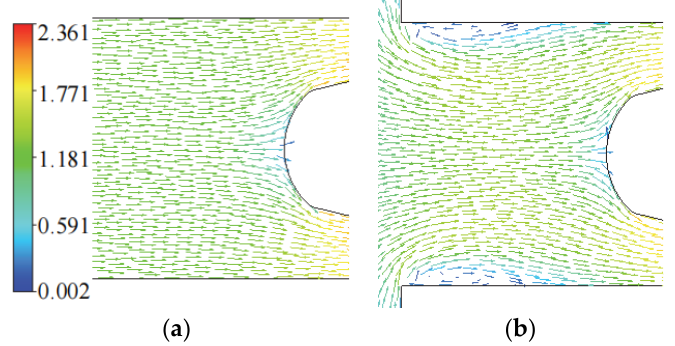
Figure 28. Velocity vector at the turbine inlet [119]. ( a ) Without considering the free surface; ( b ) considering the free surface.